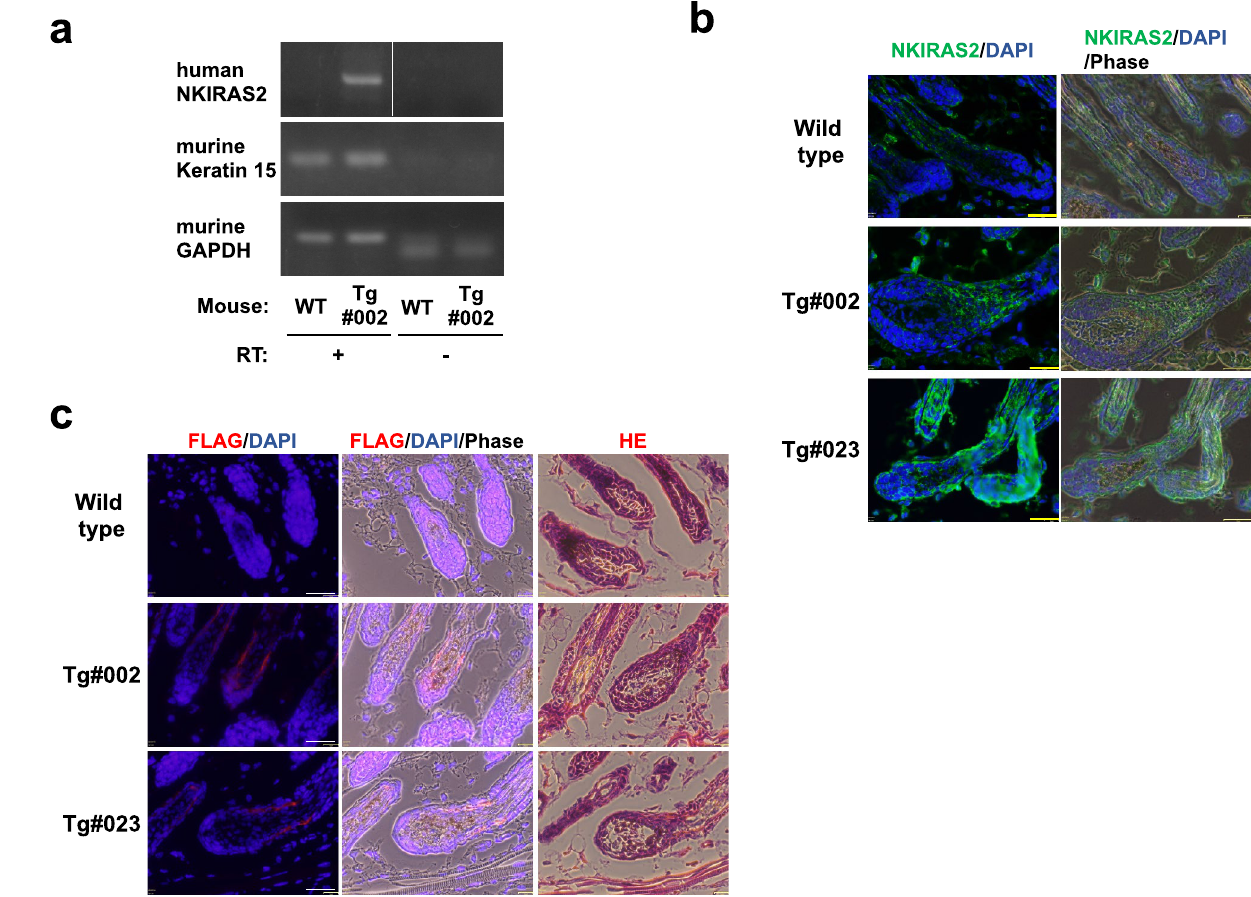
Figure 2. Expression of ectopic NKIRAS2 driven by the K15 promoter in follicle bulges. ( a ) To detect the expression of transgenic NKIRAS2 mRNA, total RNA was prepared from a keratinocyte-enriched cellular fraction of wild type and NKIRAS2 #002 transgenic mice, and then utilized for RT-PCR with/without reverse transcription (RT). To confirm the presence of the cellular population from follicle bulges, the expression of K15 mRNA was examined. The expression of transgenic NKIRAS2 is shown by RT-PCR using specific primers for human NKIRAS2. GAPDH is shown as an internal control. ( b ) Ectopic expression of NKIRAS2 driven by the K15 promoter in follicle bulges of wild type and two lines of transgenic mice is shown using immunofluorescence analysis with an anti-NKIRAS2 antibody (green). Nuclei of all cells in the epidermal section were stained with DAPI (blue). Scale bar = 153 µm ( c ). To confirm that exogenous NKIRAS2 was expressed, NKIRAS2 was stained with an anti-FLAG antibody (red). To show follicular bulge, H&E staining was performed. Scale bar = 32